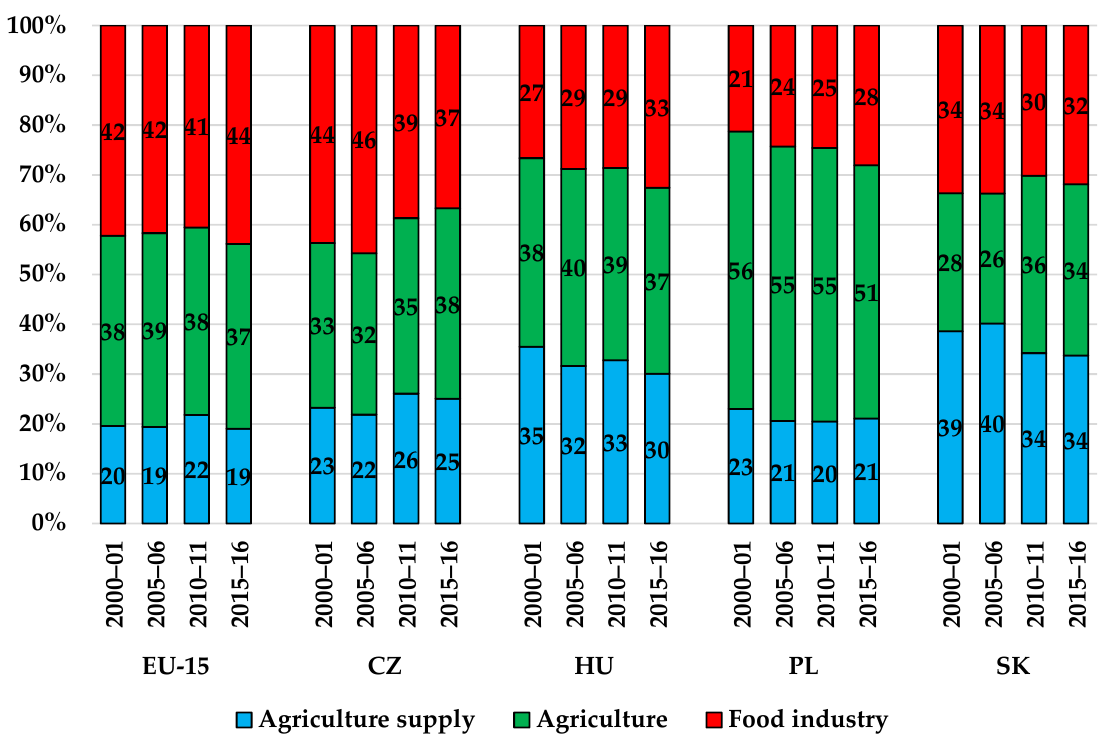
Figure 4. The structure of energy consumption by production sectors. Source: Own calculations based on WIOD Environ- mental Accounts and WIOD national input–output tables.